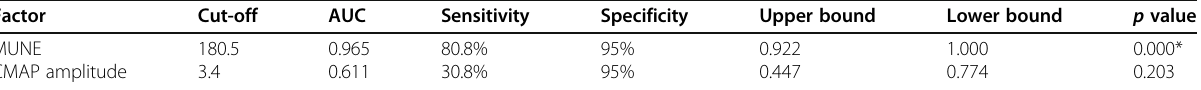
Table 3 Diagnostic sensitivity and specificity of MPS MUNE and CMAP amplitude in ALS patients Factor Cut-off AUC Sensitivity